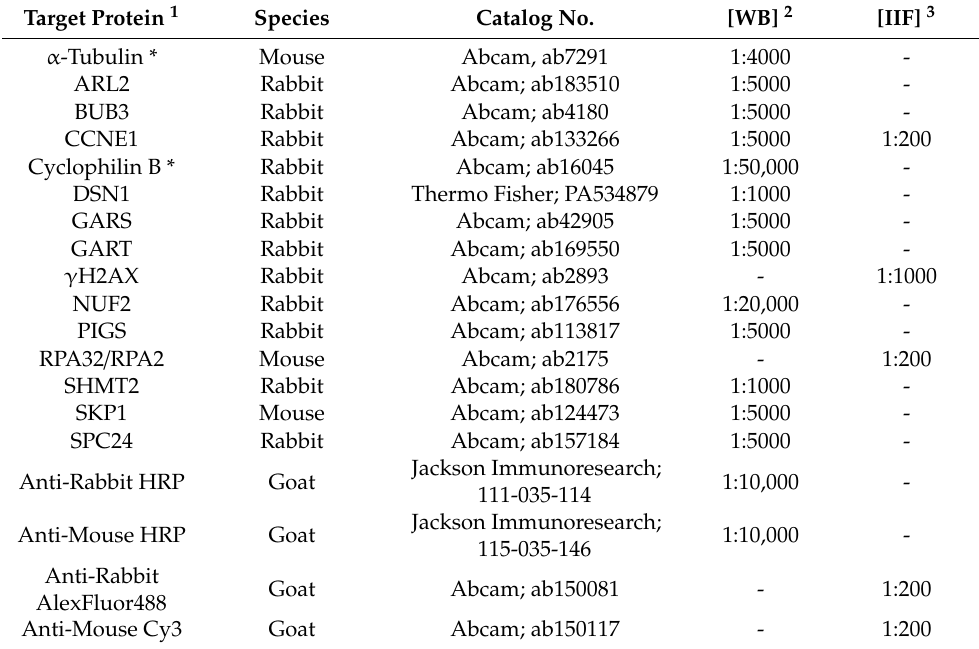
1 Proteins listed with an asterisk represent Western blot loading controls. HRP = horse radish peroxidase. 2 Concentration of antibody employed for Western blot analyses. 3 Concentration of antibody employed for indirect immunofluorescence. * identifies protein loading